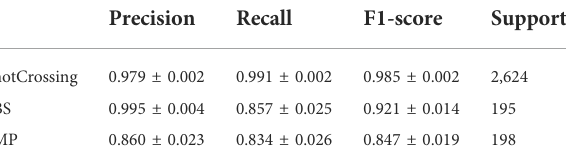
TABLE 2 Performance metrics of the cnn-caps classi fi er after correction of the labels in the previously misclassi fi ed samples. The support columns indicate the number of samples for each class. The uncertainty in each metric was estimated using the standard deviationof1,000bootstrapsamplesofthecorrectedtestdataset evaluated using the same model.